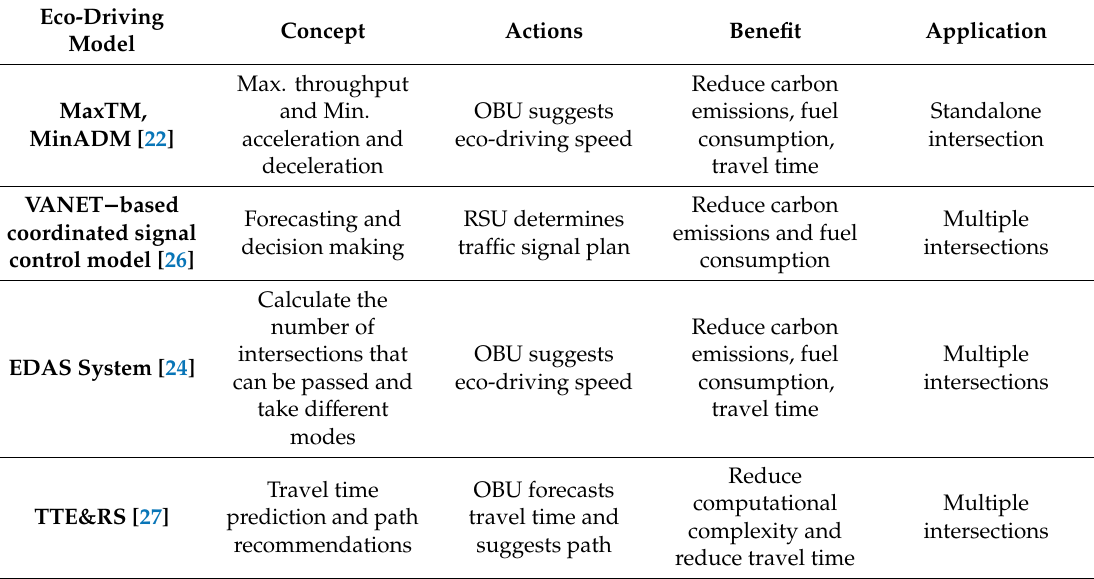
Table 2. Eco-driving